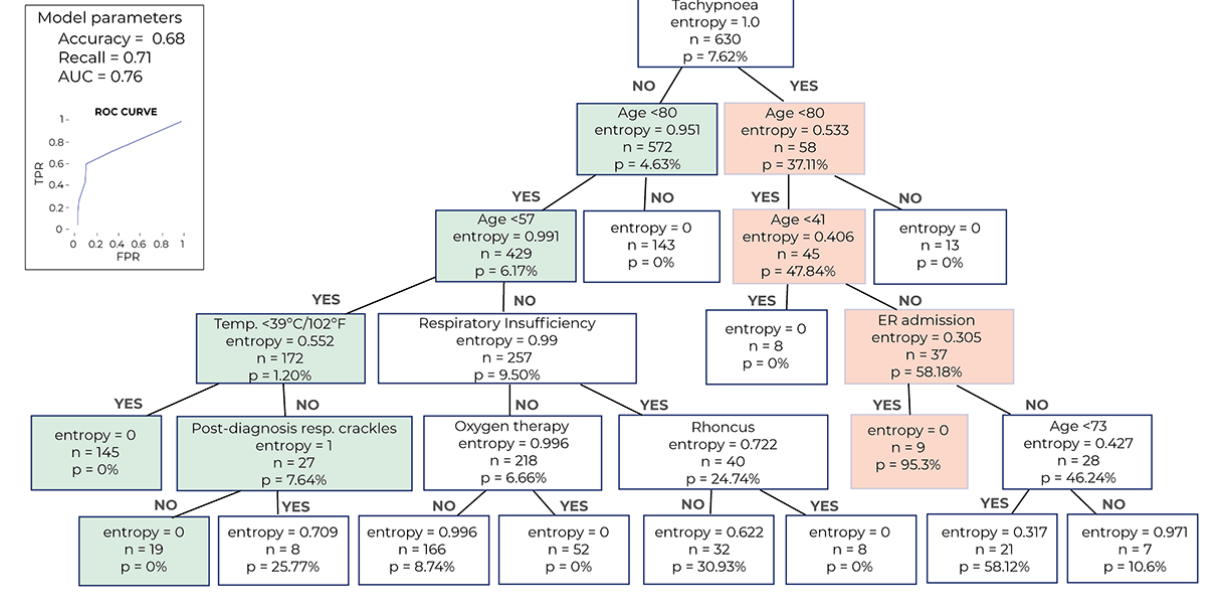
Figure 4. Decision tree of relevant clinical variables for the prediction of ICU admission in patients with COVID-19. The combination of three easily available clinical variables, namely age, temperature, and respiratory frequency, was the most parsimonious predictor of ICU admission among COVID-19 patients. The number of patients, probability (p) of ICU admission predicted by the model, and level of entropy (a measure indicating how mixed or pure the classification is, where 0 indicates optimal separation of classes) are indicated in each box. The green pathway indicates that patients with no tachypnea, age <56 years, and temperature <39 ºC (OR >39 ºC without respiratory crackles) did not require ICU admission. In contrast, the red pathway indicates that patients aged 40-79 years, who presented with tachypnea, and who delayed their visit to the emergency department after being seen in primary care were likely to be admitted in the ICU. For this model, we obtained accuracy, recall, and AUC values of 0.68, 0.71, and 0.76, respectively (top right panel). AUC: area under the curve; FPR: false positive rate; resp.: respiratory; ROC: receiver operating characteristic; TPR: true positive